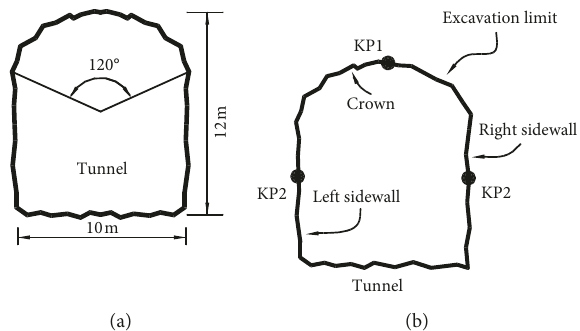
Figure 3: Geometry of mining tunnel and concerning point. (a) Geometry of mining tunnel; (b) concerning